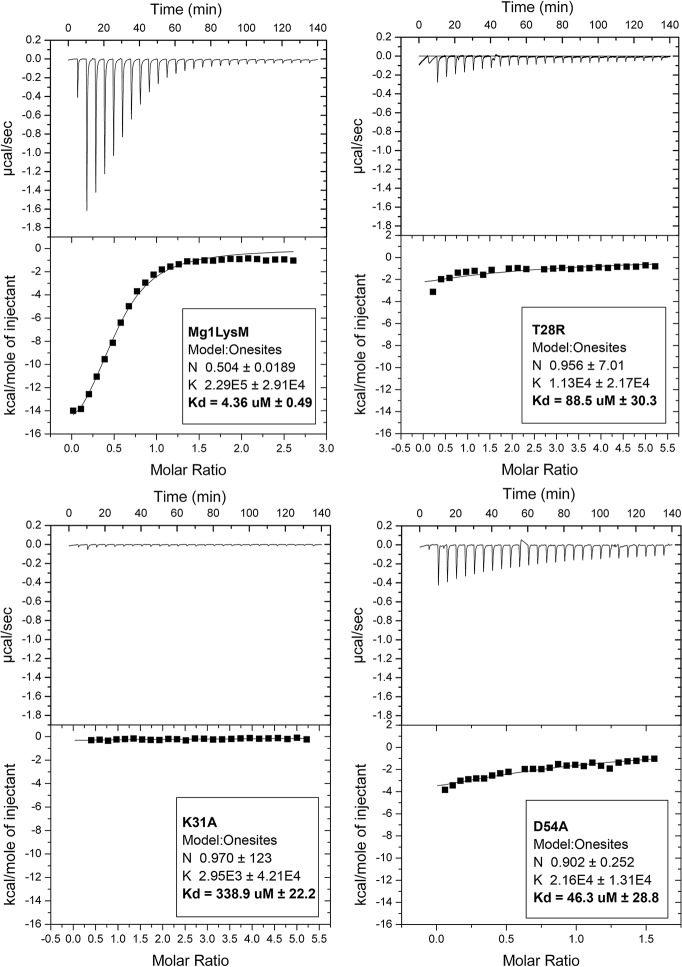
Two Mg1LysM protomers bind a single chitin hexamer with high affinity.Isothermal titration calorimetry of (GlcNAc)6 binding by wild-type Mg1LysM produced in E. coli, and the mutants T28R, K31A and D54A. The dissociation constant (Kd) and the stoichiometry (N) of the interactions are indicated.